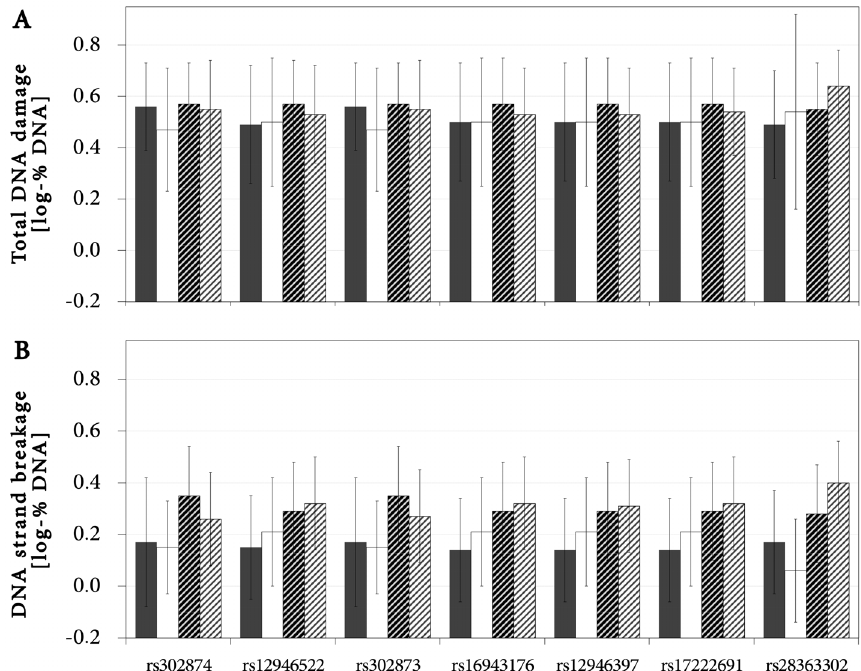
Figure 3. Log-transformed levels of total DNA damage (A) and DNA strand breakage (B) expressed as logarithmically-transformed relative amount of DNA in respective comet tails in whole blood leukocytes of healthy controls (solid) and BrC cases (stripes) carrying the respective wild-type ( wt- ; dark columns) or rare-allele containing ( var -; light columns) genotypes. Only dominant genetic model was assumed. Identification of genotypes as wild-type or rare-allele containing (i.e. heterozygotic and rare homozygotes) with reference to Table 3, in which individual genotypes for each SNP are ordered accordingly. Data are presented as means (columns) 6 SD (error bars). Logarithmical transformation was employed in order to normalize the distribution of raw comet assay data for the purpose of ANOVA/ANCOVA analysis. Total DNA damage data for wt -controls, var -controls, wt- cases and var -cases, respectively (log-%): rs302874: 0.56 6 0.17, 0.47 6 0.24, 0.57 6 0.16, 0.55 6 0.19; rs12946522: 0.49 6 0.23, 0.50 6 0.25, 0.57 6 0.17, 0.53 6 0.19; rs302873: 0.56 6 0.17, 0.47 6 0.24, 0.57 6 0.16, 0.55 6 0.19; rs16943176: 0.50 6